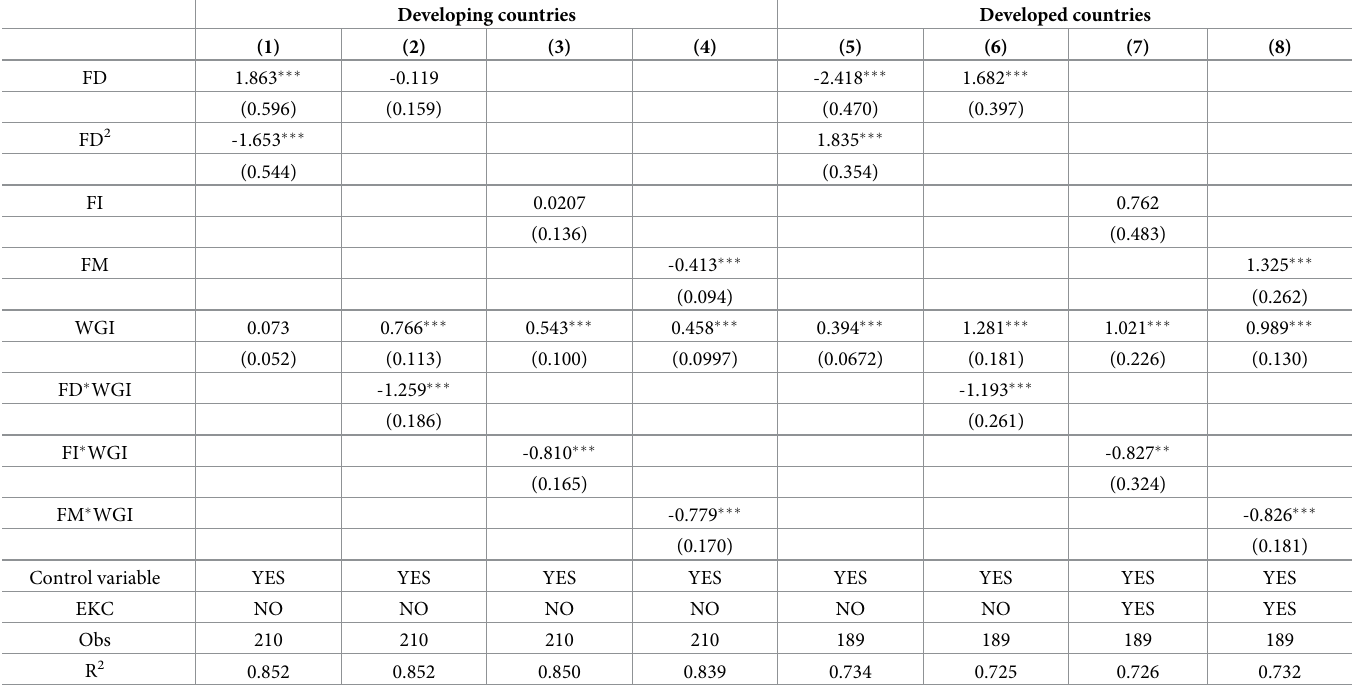
Table 5. Heterogeneity test results of economic development